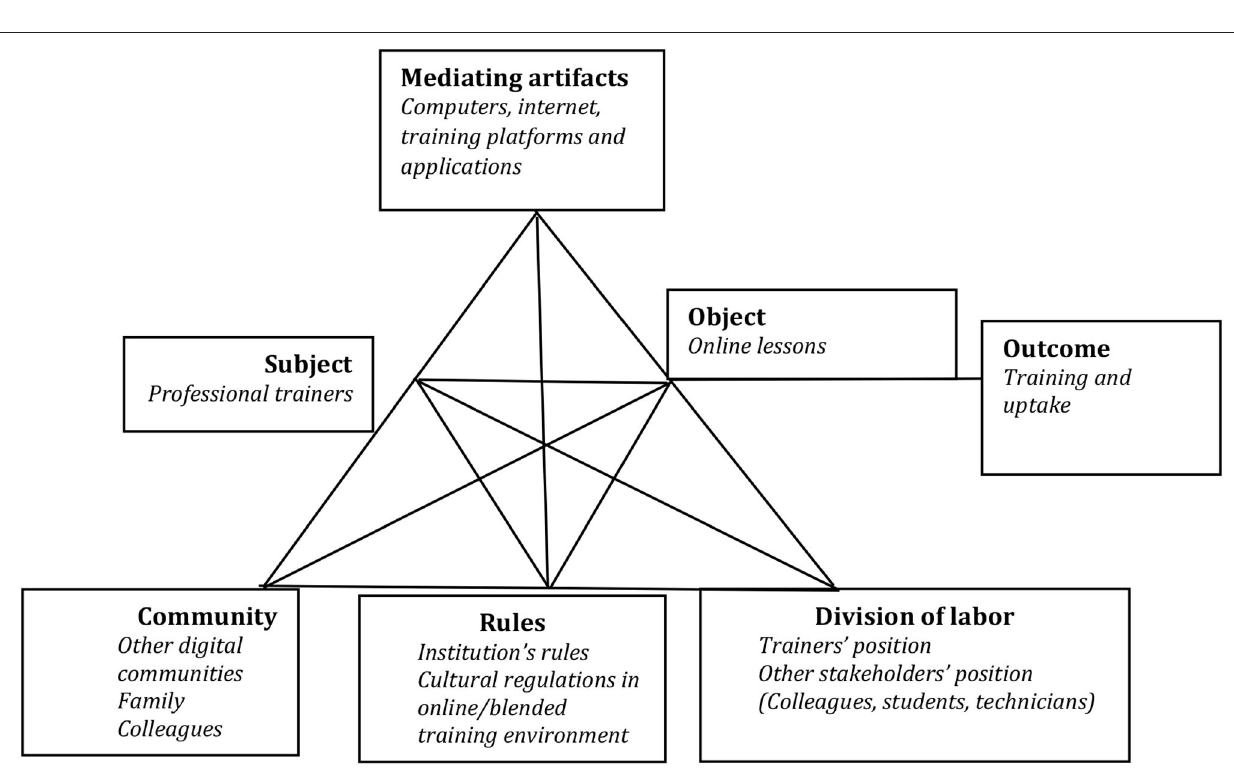
FIGURE 2 | Model of instruction activities in the online classroom [adapted from Engeström